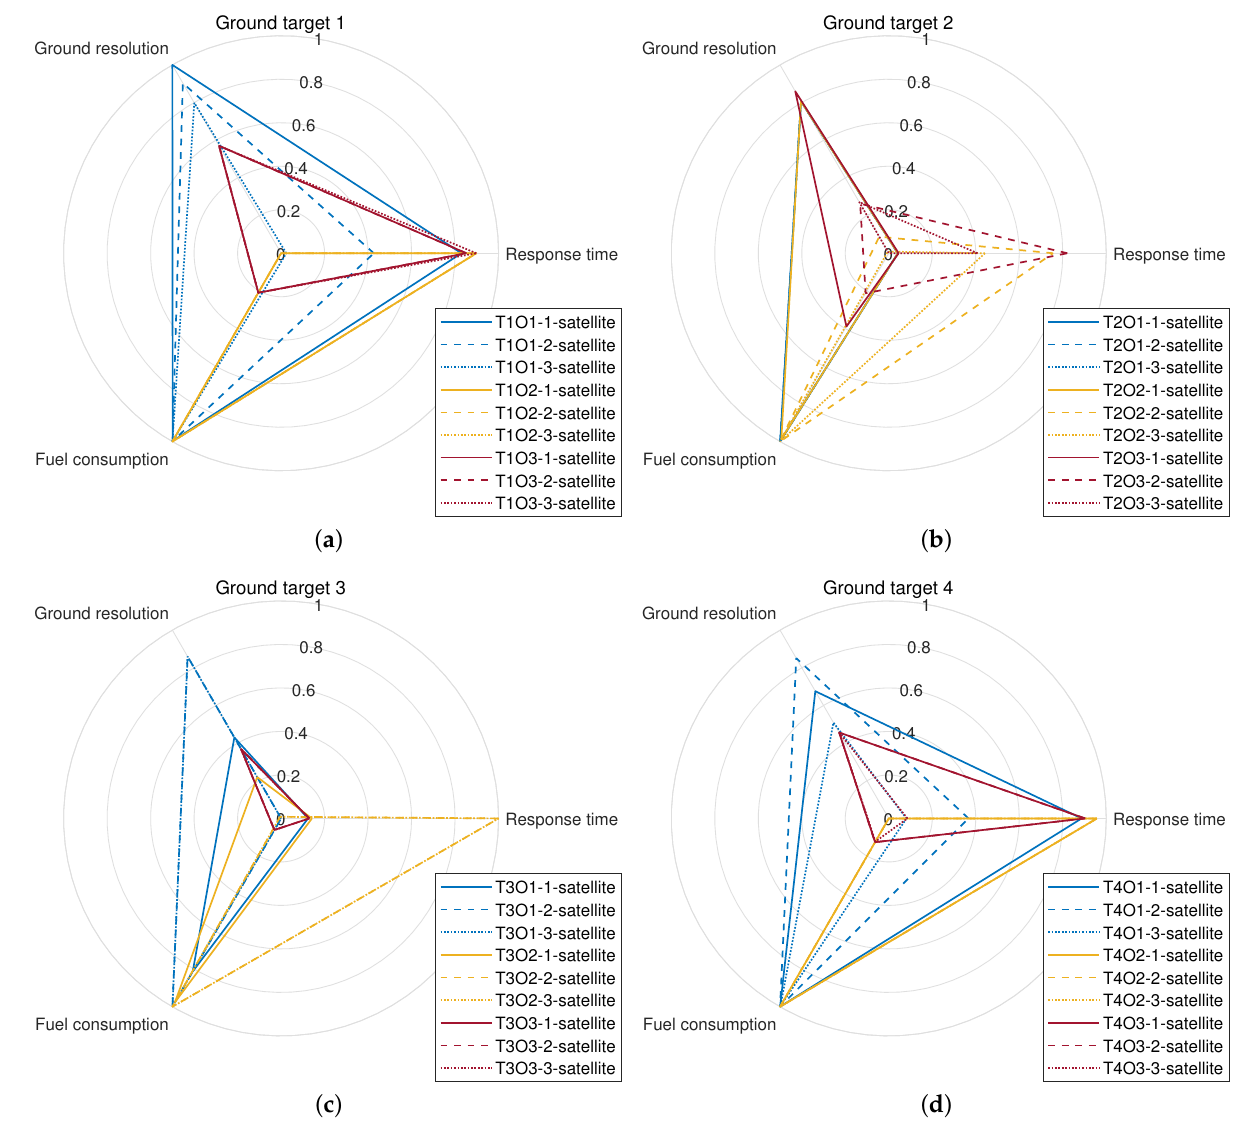
Figure 5. Simulation results by varying the number of satellite. ( a ) Ground target 1, ( b ) ground target 2, ( c ) ground target 3, ( d ) ground target